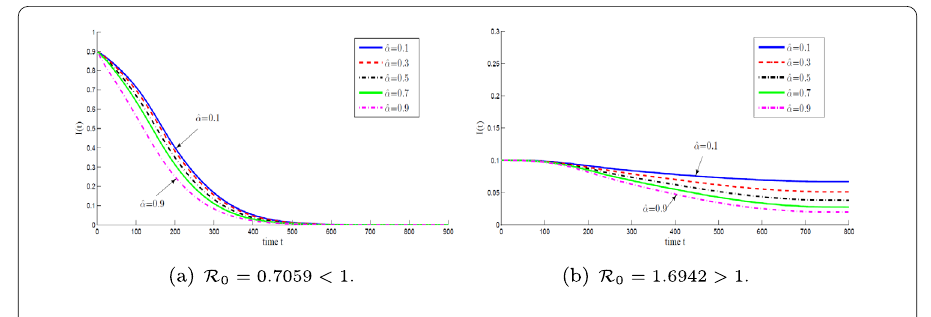
Figure 5 Evolutions of I ( t ) based on system (2.4) with varying ˆ